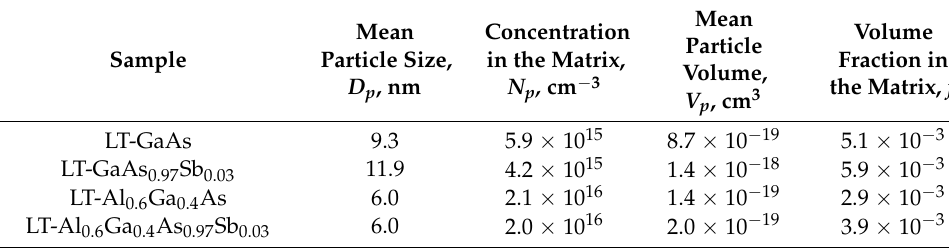
Table 1. Parameters of the nanoparticles in the samples annealed at 600° according to TEM.